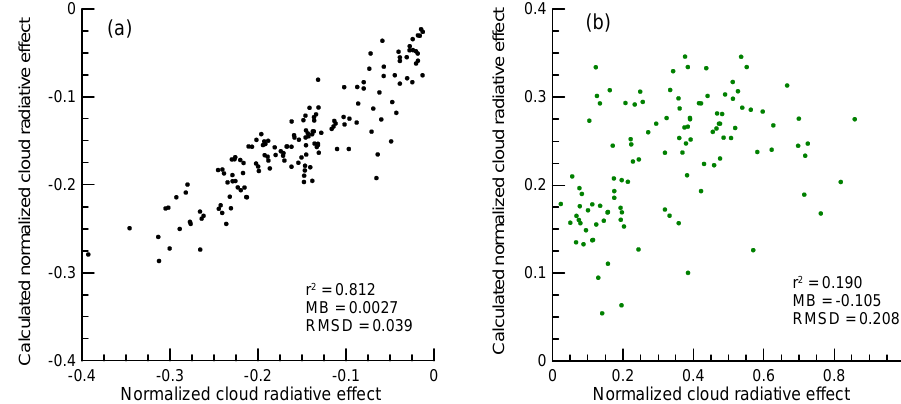
Figure 12. Scatterplot between the normalized cloud radiative effect (NCREc) calculated from the multilinear regression and the normalized cloud radiative effect (NCRE). Graphs for global ( a ; 151 data points) and diffuse ( b ; 104 data points) PAR are shown.